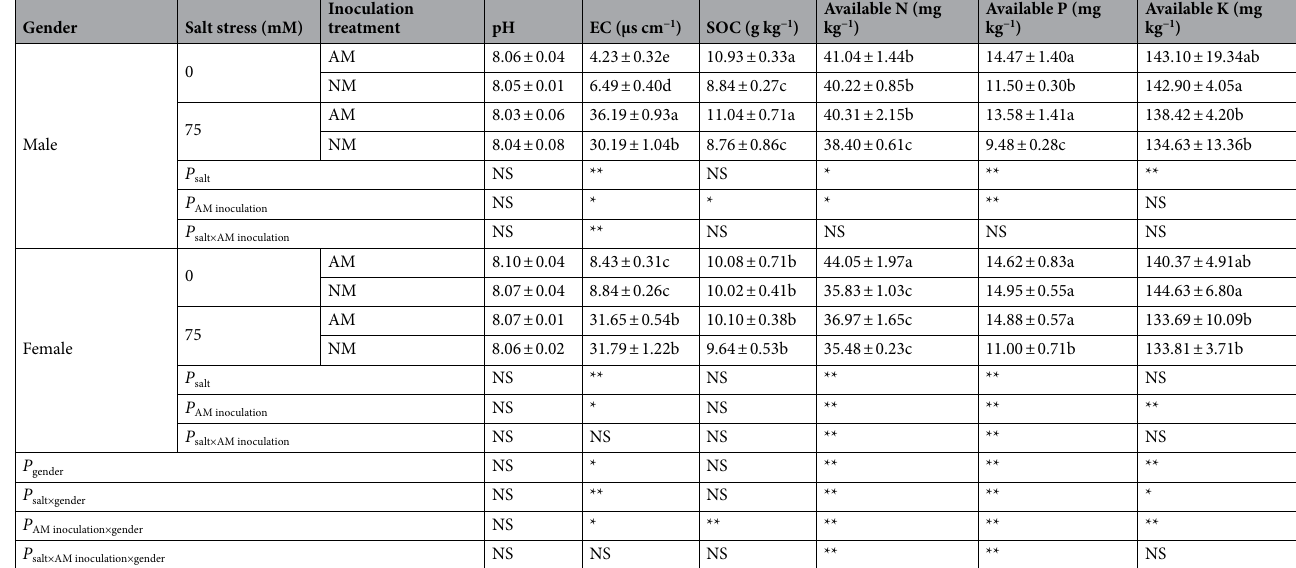
Table 3. Effects of exogenous AM inoculation on soil physical and chemical properties in the rhizosphere of P . cathayana males and females under different salt conditions. AM, AMF inoculation; NM, non-inoculation; 0 mM, without salt stress; 75 mM, under salt stress; M, male; F, female. Different normal letters in the same column mean 5% significant differences.